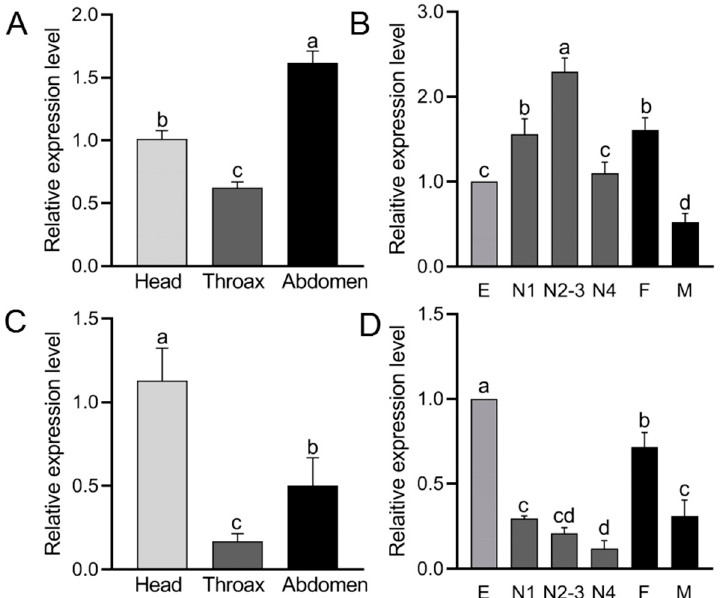
Figure 2. Expression profiles of the prophenoloxidase genes in different tissues and stages of Bemisia tabaci . ( A ) BtPPO1 expressions in different tissues. ( B ) BtPPO1 expressions in different stages. ( C ) BtPPO2 expressions in different tissues. ( D ) BtPPO2 expressions in different stages.